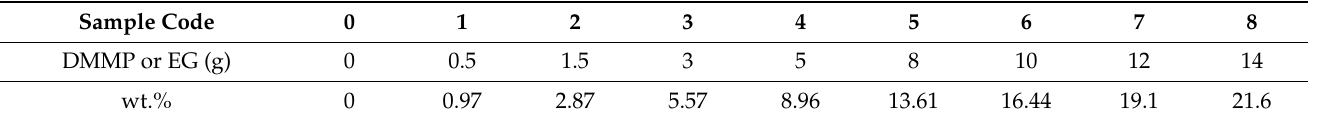
Table 1. Amount of FRs added into the foams along with their weight